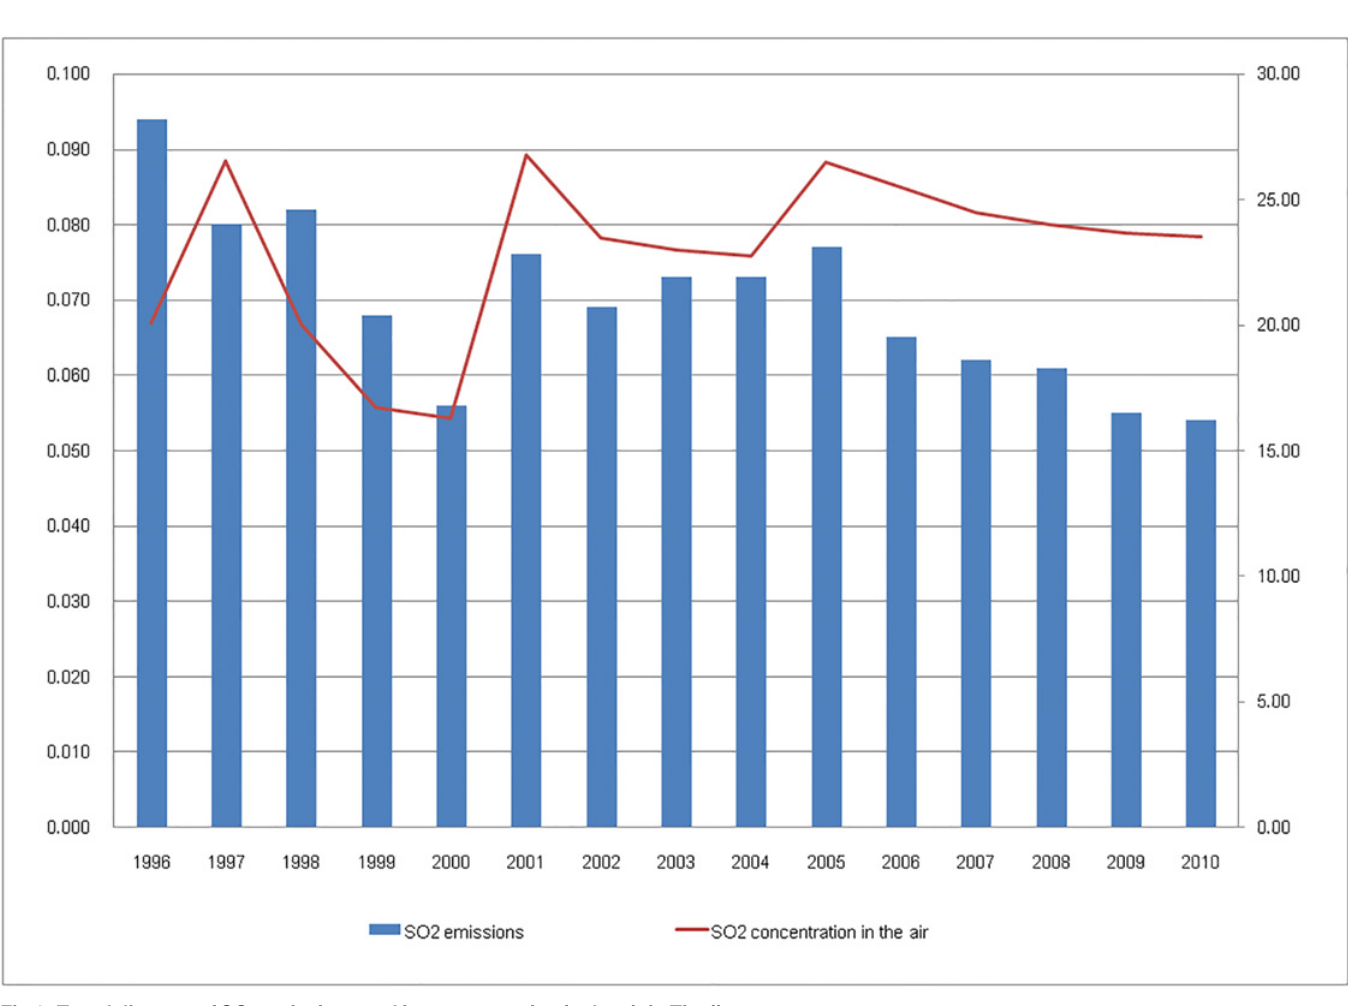
Fig 1. Trend diagram of SO 2 emissions and its concentration in the air in Tianjin